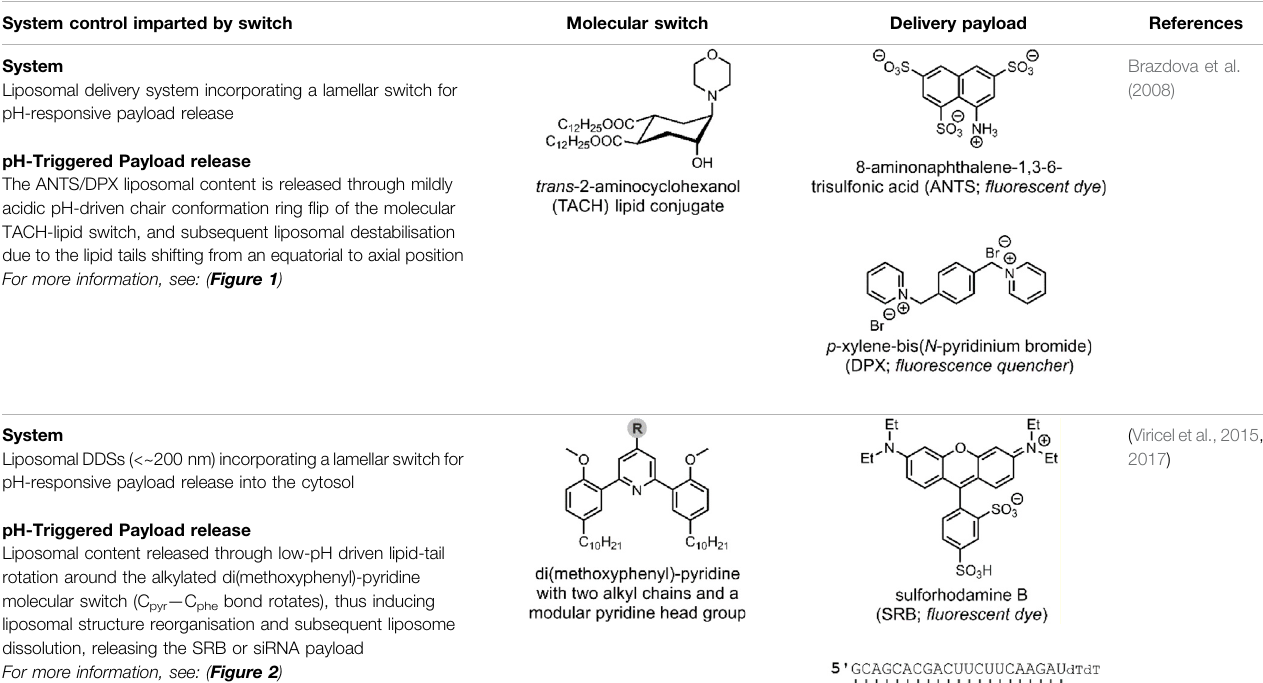
TABLE 2 | Summary of herein reviewed delivery systems incorporating molecular switches for light- and/or pH-responsive payload release. Molecular switches have been visualisedastheywouldappearpriortoactivationandpriortoformationoflargernanostructures.Deliverypayloadhasbeenvisualisedisasitwouldappearafterrelease, cleavage, or activation. The sequence for the siRNA example has been sourced from (Eckstein,